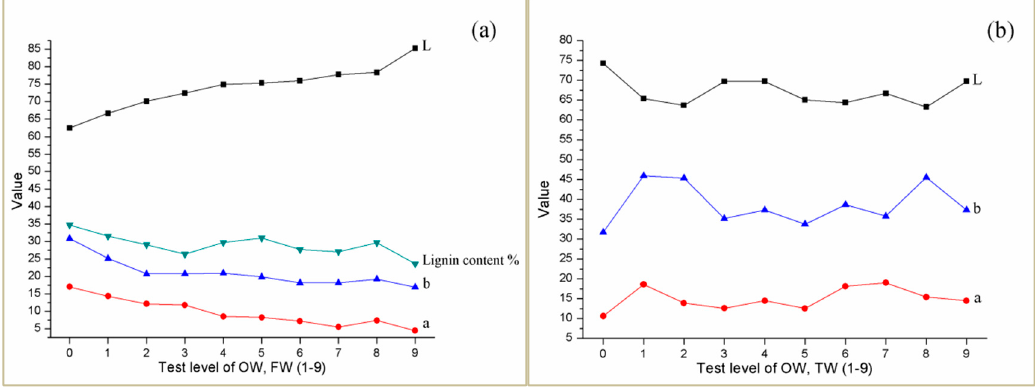
Figure 3. The color difference of OW, ( a ) FW and ( b ) TW.